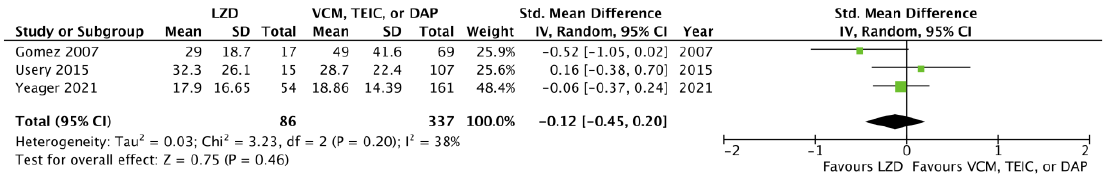
Figure 5. Forest plots of hospital length of stay in patients with MRSA bacteremia treated with LZD versus VCM, TEIC, or DAP. The vertical line indicates no significant difference between the groups compared. The standardized mean differences are represented by diamond shapes, and 95% CIs are represented by horizontal lines. Squares indicate point estimates, and the square size indicates the weight of each study included in the meta-analysis. MRSA, methicillin-resistant Staphylococcus aureus ; CI, confidence interval; LZD, linezolid; VCM, vancomycin; TEIC, teicoplanin; DAP, daptomycin.